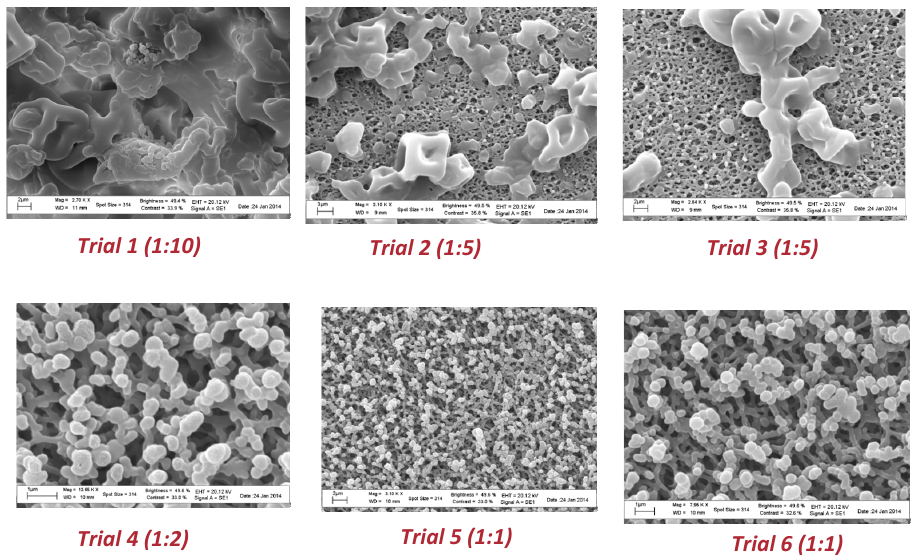
The same procedure was followed to verify bacteria release after incubation in PBS at pH 7.5, and the SEM images are reported in Figure 6. A good release of cell content could be observed after 24 h by spotting 10 µL of the digested medium onto a filter. Figure 5. SEM images of microparticles from spray drying experiments after 2 h in HCl.